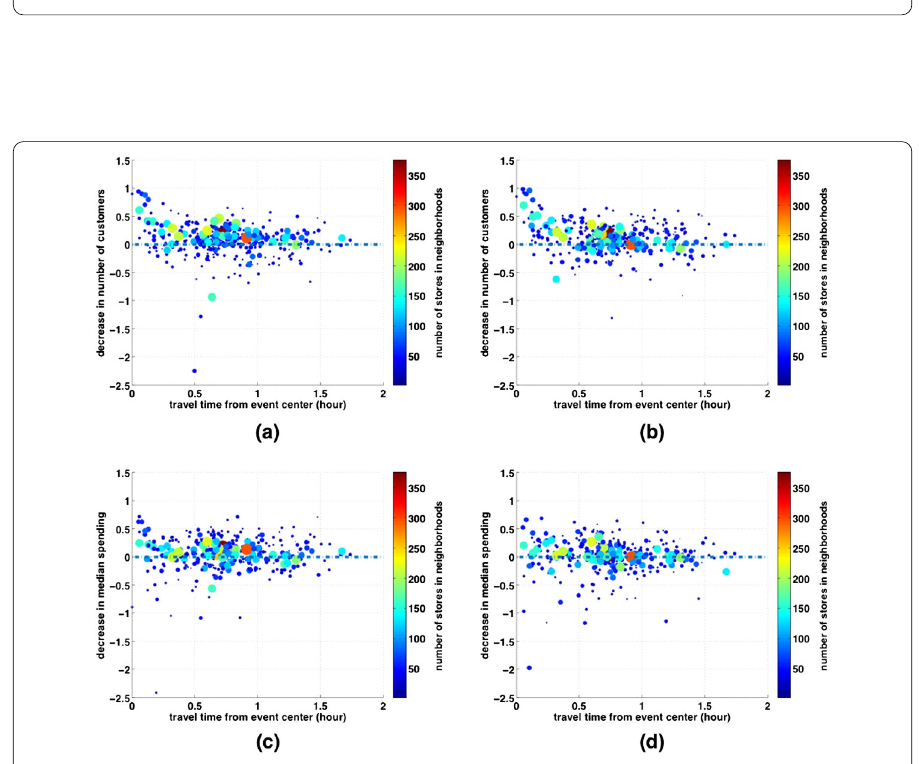
Figure A4 The decrease in the two behavioral indexes for neighborhoods that are located at different travel time from the event center. ( a ) number of customers on Day 62; ( b ) number of customers on Day 77; ( c ) median spending on Day 62; ( d ) median spending on Day 77. Both the size and color of the circles indicate the number of stores in each